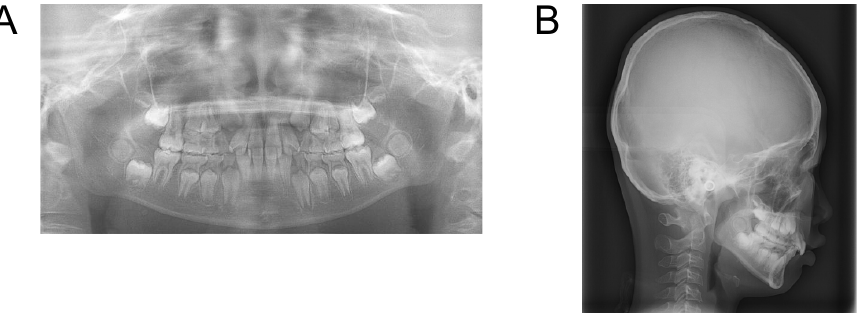
Figure 3. Panoramic radiograph ( A ) and lateral roentgenographic cephalogram ( B ) of Case 1 at initial examination.